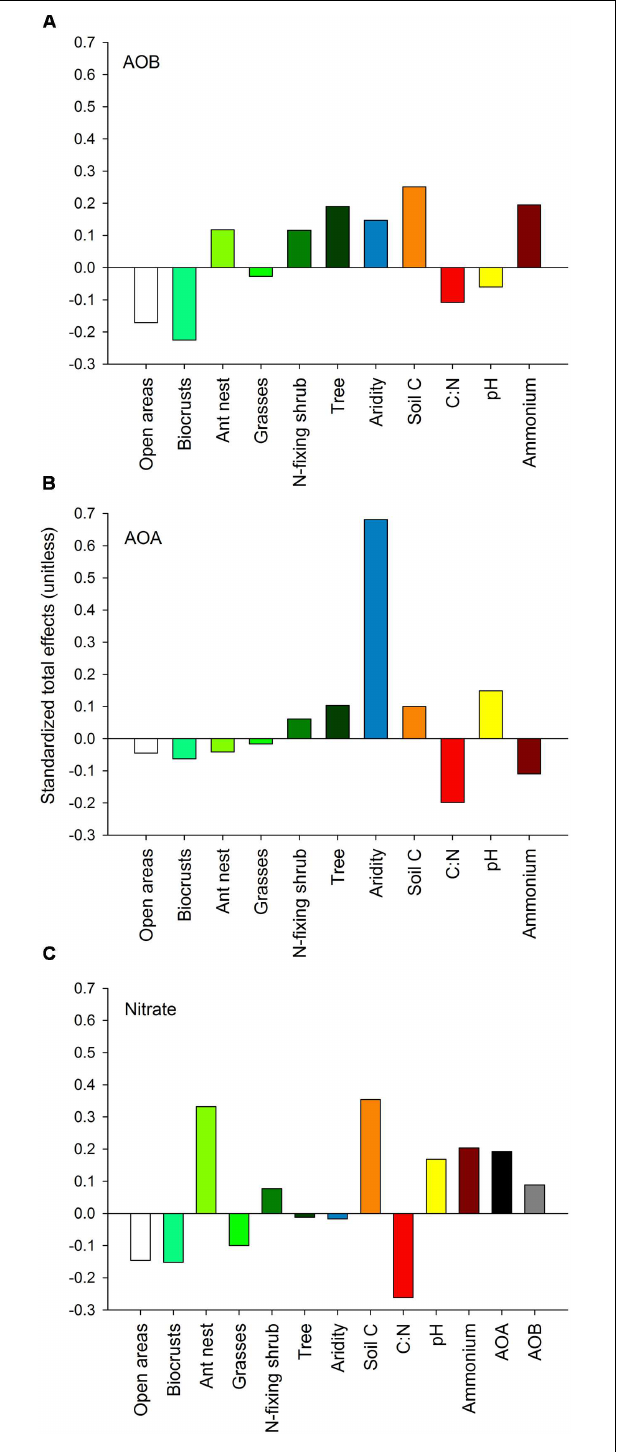
FIGURE 5 | Standardized total effects (direct plus indirect effects) derived from the structural equation modeling, including the effects of aridity and the different microsites evaluated on the abundance of AOB (A) and AOA (B) and on nitrate availability (C). The total effects of aridity, soil C, pH, C:N and ammonium on AOB and AOA abundance and nitrate availability were averaged from all six models in Figure 4 .